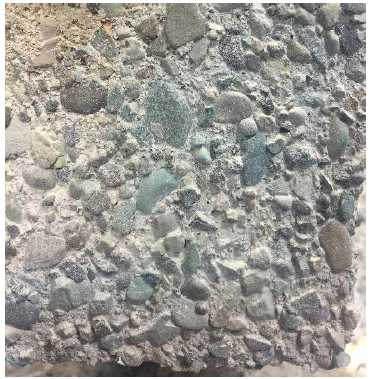
Figure 12. Visual inspection of OPC sample (100 × 100 mm) exposed to sulfuric acid after 6 months.